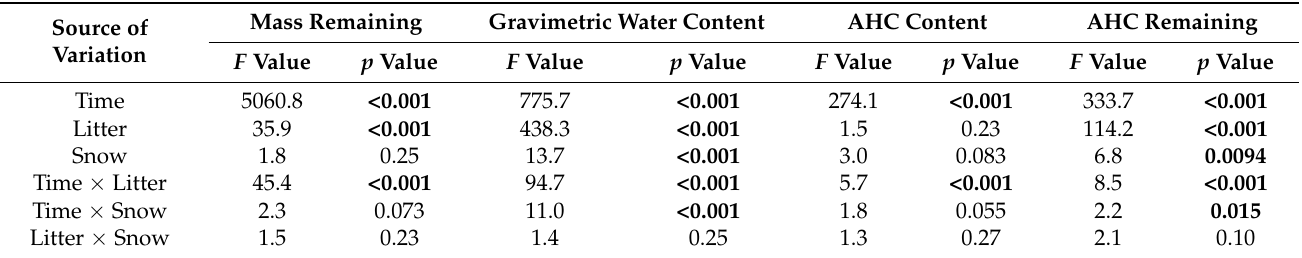
Table 3. Results of repeated measures ANOVA testing for the effects of litter species and variation in snow depth over time.